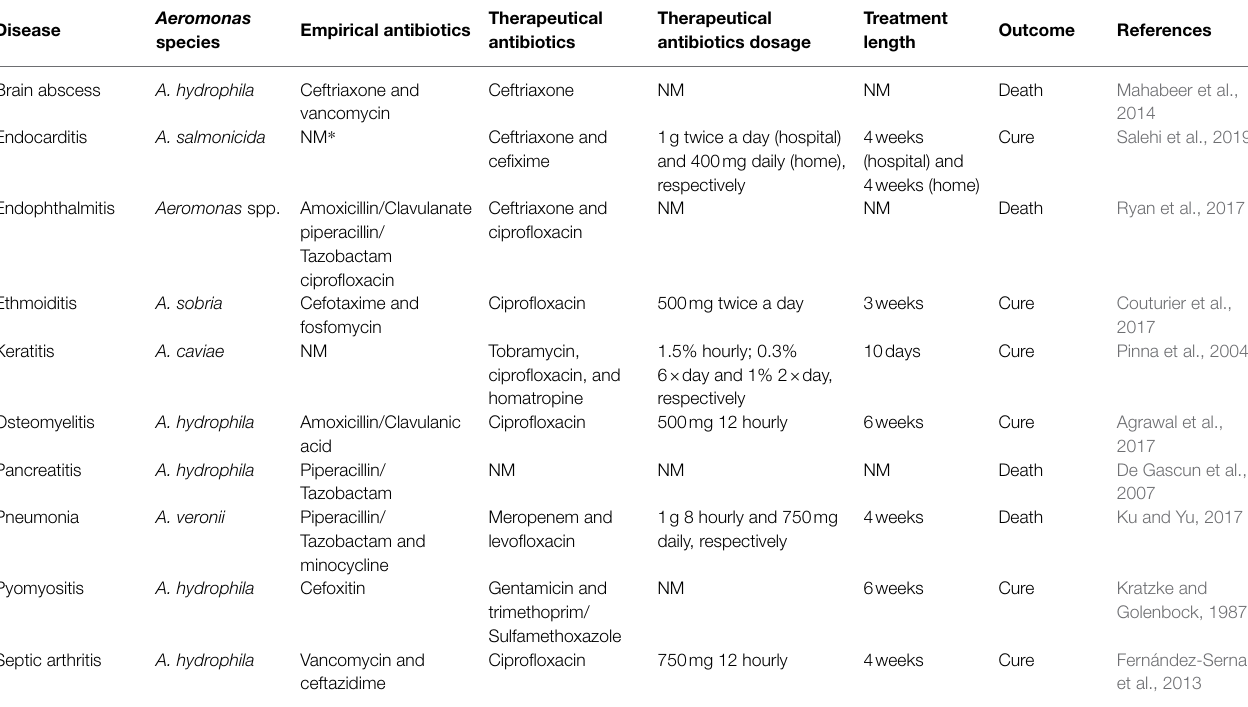
TABLE 1 | Antimicrobial strategies and respective outcomes for uncommon Aeromonas human health